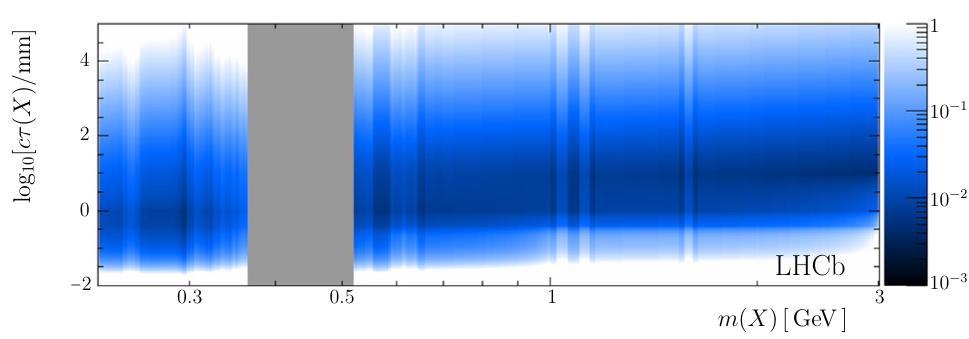
Figure 11 . Upper limits at 90% con(cid:12)dence level on the (cid:13) { Z scenario discussed in the text. Here, X denotes a composite HV vector